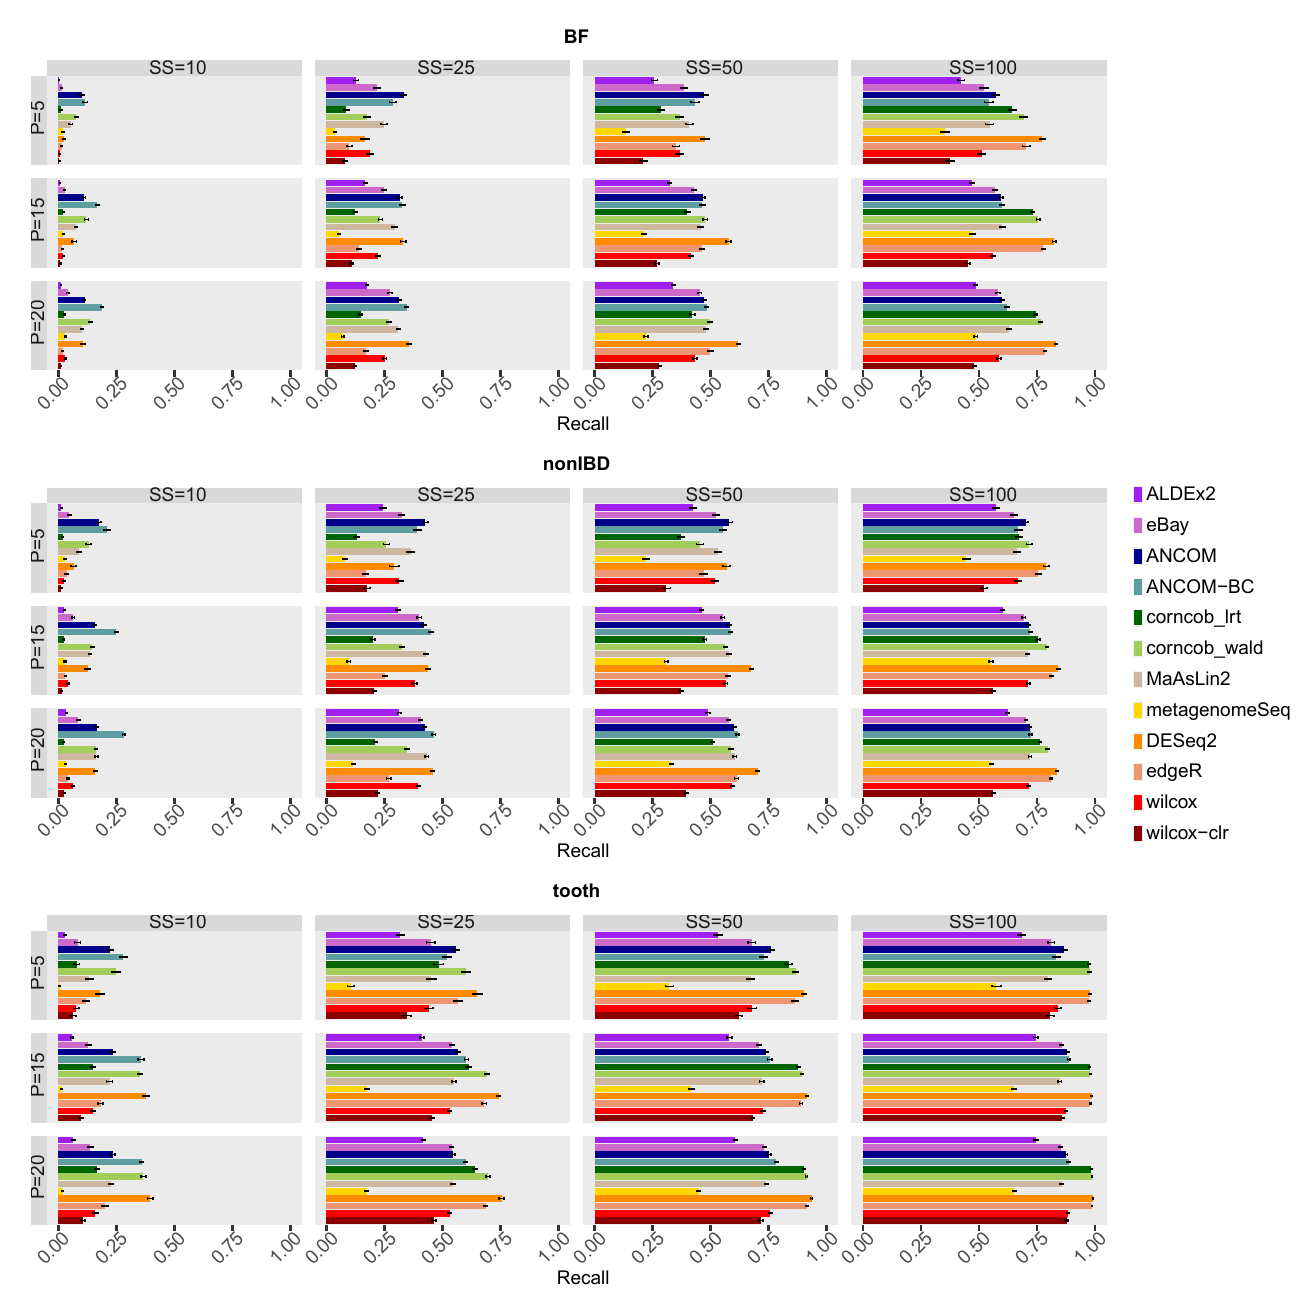
Fig 7. Recall of each differential abundance method for each dataset considered in the comparison in simulations with reduced variability. In each set of boxes corresponding to the dataset, different percentages (P) of simulated DA features are on rows, while different sample size (SS) values are on columns. The recall values are averaged over the 50 simulations and the bars show the standard